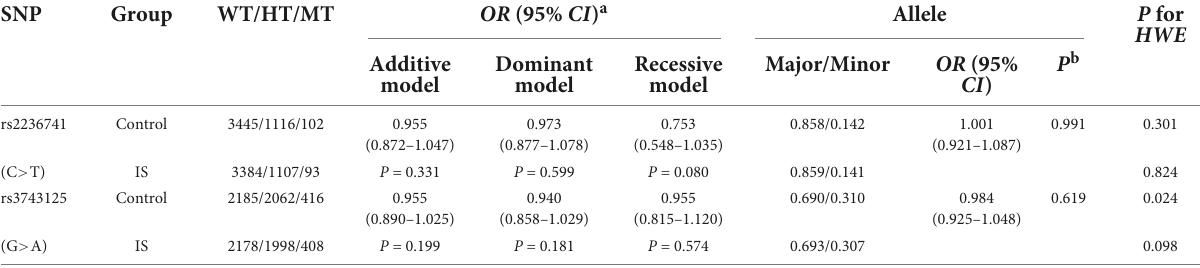
TABLE 2 Association analyses of THBS1 variants and the risk of ischemic stroke in the case-control study. SNP Group